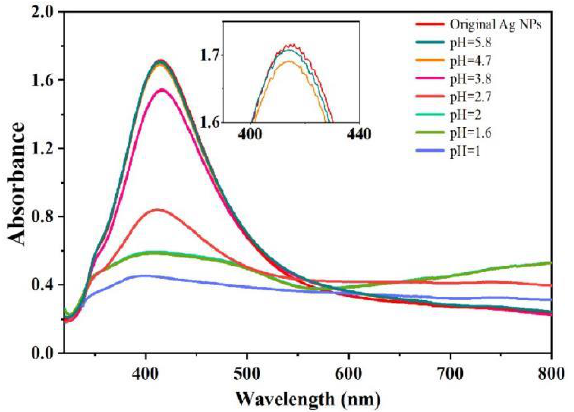
Figure 1. Extinction spectra of Ag NPs with different concentrations of phosphoric acid as the aggregator.